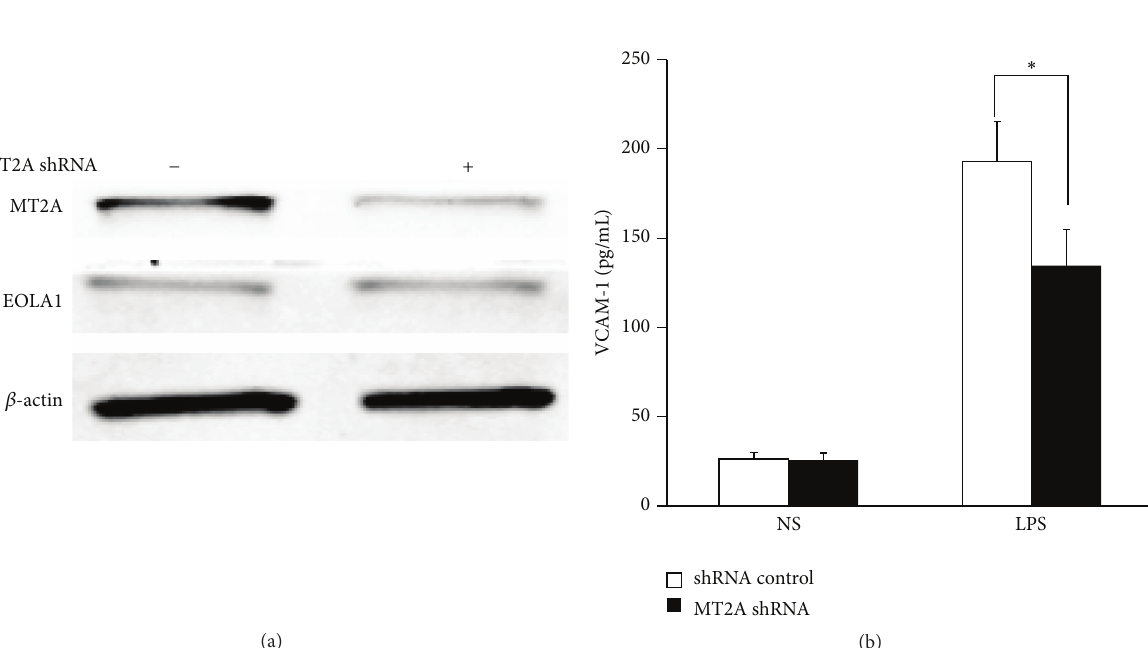
Figure 5: EOLA1 mediates LPS-induced VCAM-1 production by MT2A. (a) ECV304 cells were transfected with MT2A shRNA or control shRNA, and the cells were lysed and analyzed by Western blotting with anti-MT2A or ant-EOLA1 antibody, 𝛽 -actin as a loading control. (b) ECV304 was transfected with MT2A shRNA or control shRNA and then stimulated with LPS (100ng/mL) for 6 h. VCAM-1 production was assayed by ELISA. Data represent the mean ± SD of three independent experiments ( ∗ 𝑝 < 0.05